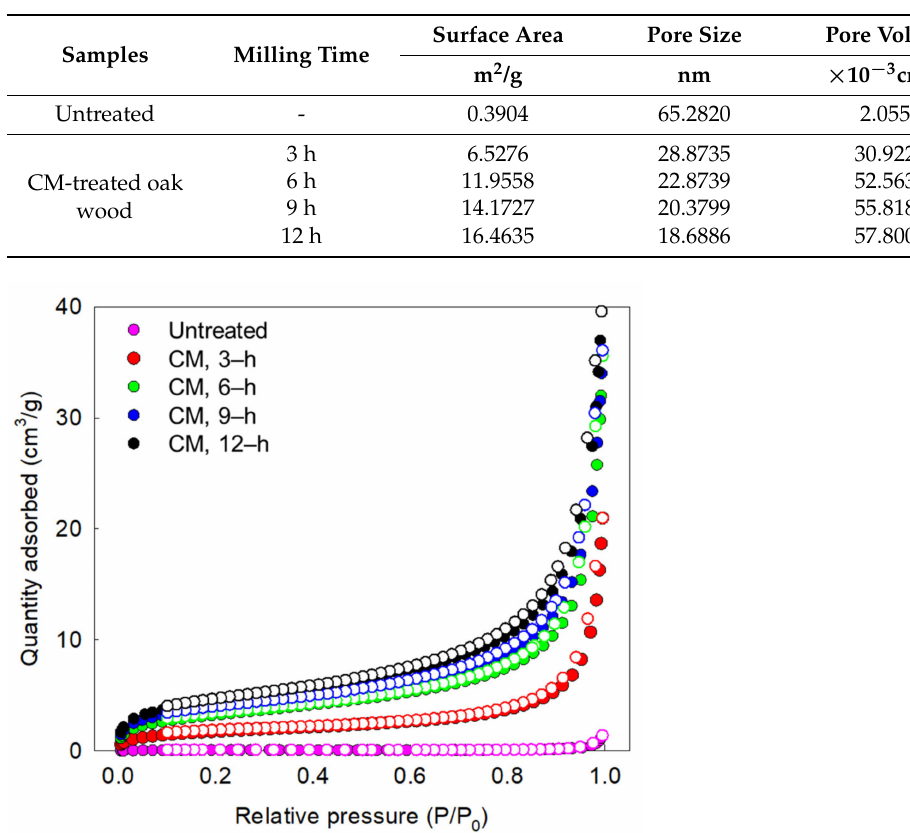
Table 2. Surface area, pore size and pore volume of untreated and CM-treated oak wood.